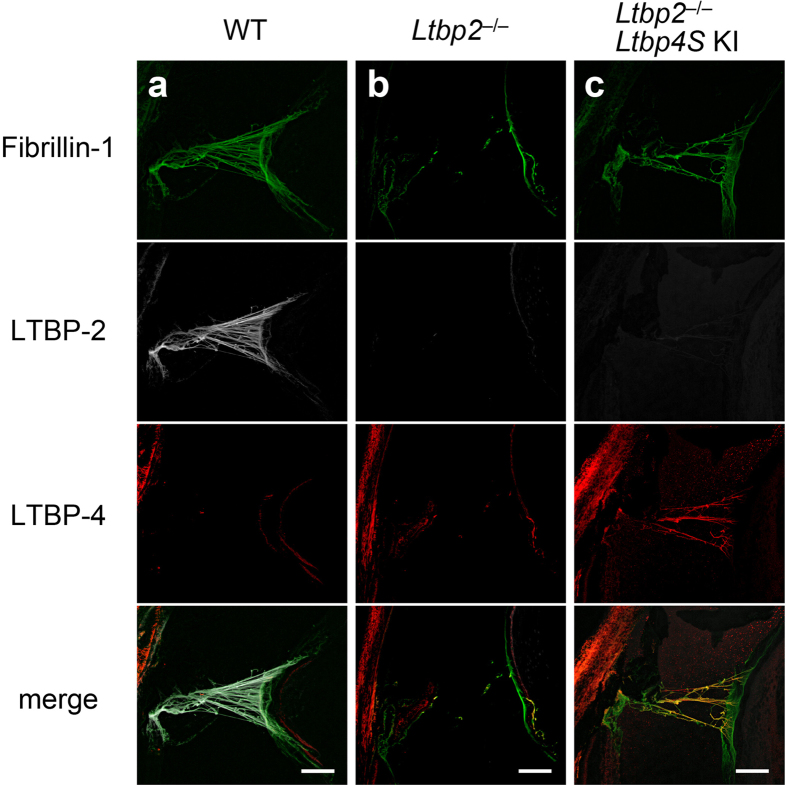
Restoration of ciliary zonule formation in Ltbp2−/−; Ltbp4S KI mice.Ltbp4S KI mice ubiquitously expressed LTBP-4S in the whole body, including ciliary bodies, whereas LTBP-4 was not expressed in ciliary bodies of wild type mice. By crossing these mice with Ltbp2−/− mice, Ltbp2−/−; Ltbp4S KI mice were produced, and ciliary zonule formation of the mouse eyes was visualized using immunofluorescent analysis, as in Fig. 5. LTBP-2 and fibrillin-1 co-localized on ciliary zonules of wild type mouse eyes, but fibrous fibrillin-1 staining was largely absent in the Ltbp2−/− eye. Ectopic expression of LTBP-4 in ciliary bodies restored ciliary zonule formation in Ltbp2−/−; Ltbp4S KI mouse eyes. Bars: 100 μm.